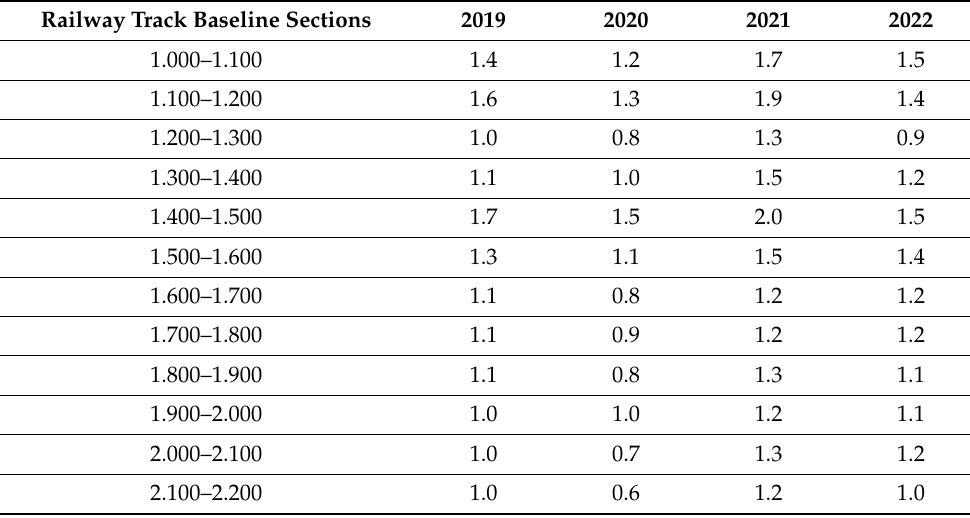
Table A2. Estimates of the railway track condition—absolute J , object No. R 143_1_2. Railway Track Baseline